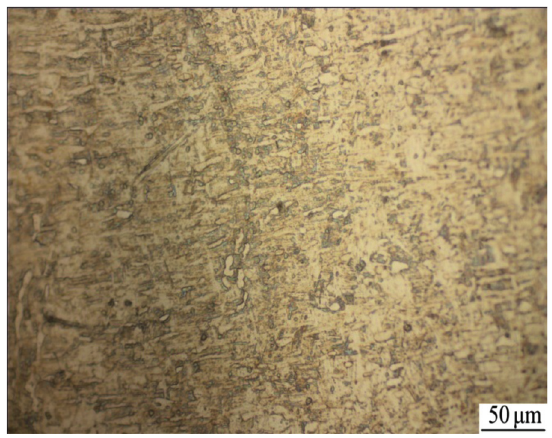
Figure 13 : Microstructure of Ti – 6Al – 4V alloy at 1,223 K and 0.01 s − 1